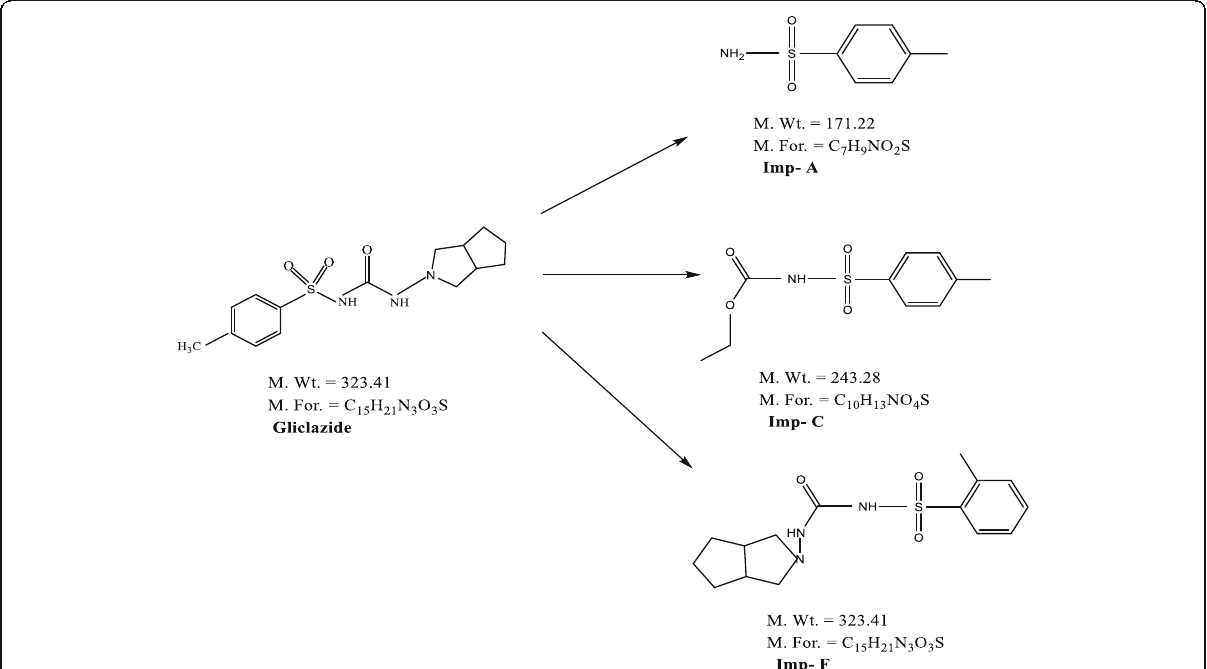
Fig. 1 Degradation-related impurities of gliclazide. a Test sample treated with acid. b Test sample treated with alkali. c Test sample treated with